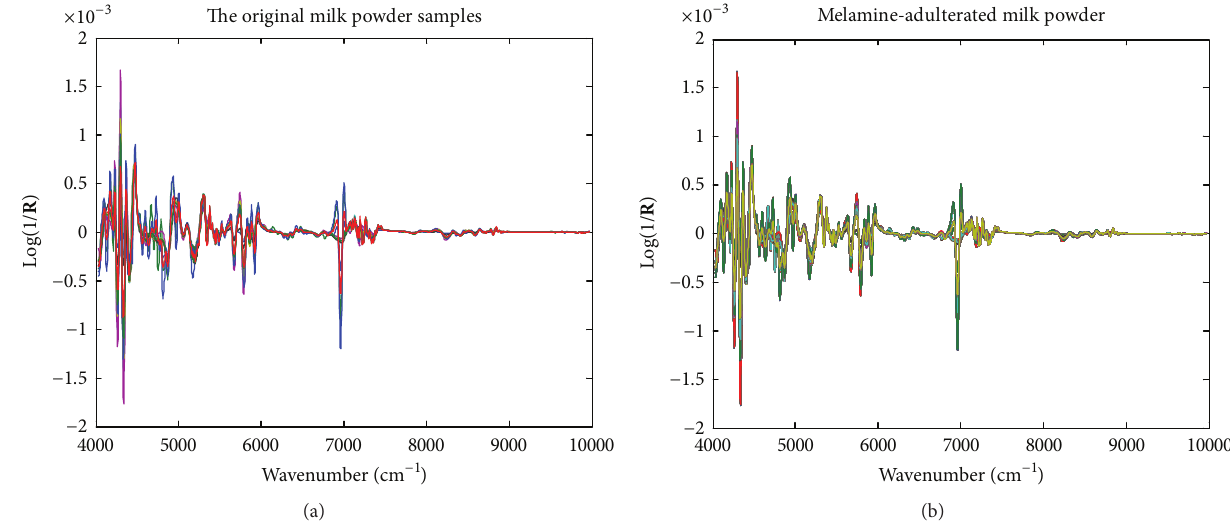
Figure 2: The second-order derivative (D2) spectra of the original and melamine-adulterated milk powder samples.